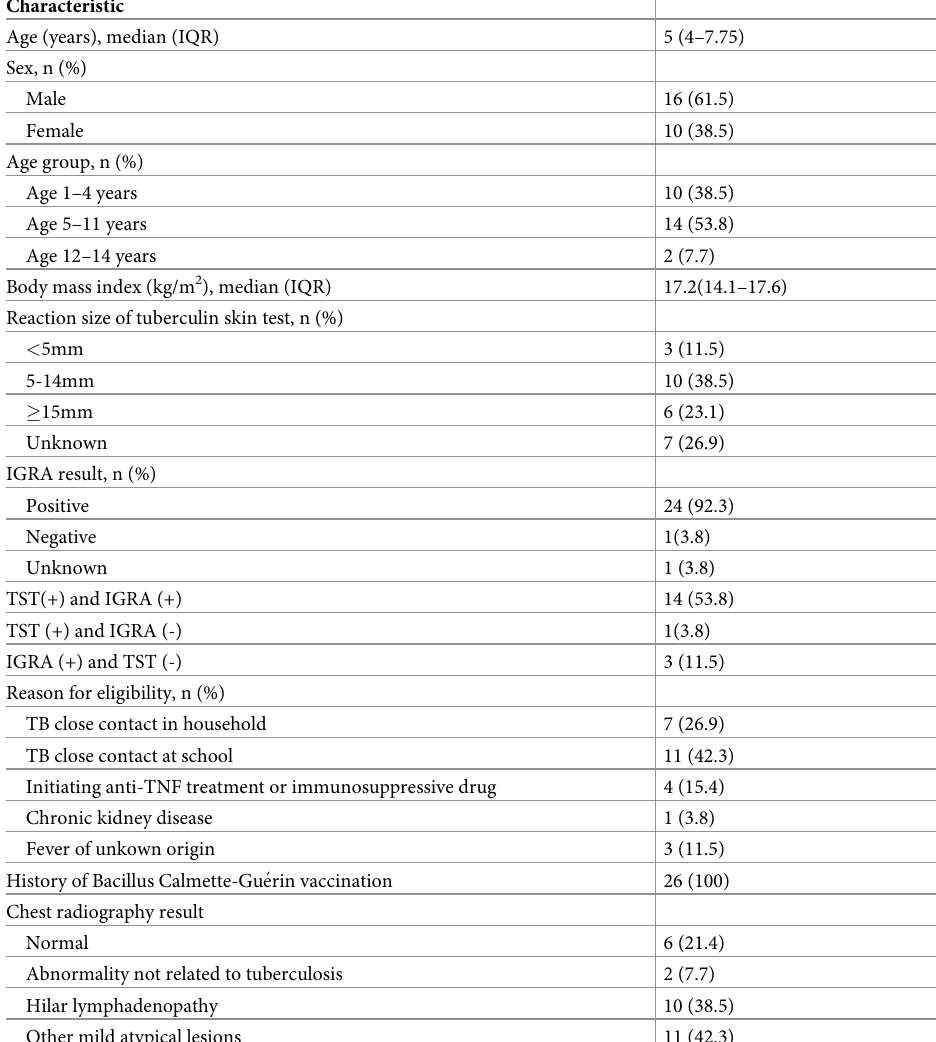
Table 1. Clinical and demographic characteristics of children in the 3 months of weekly rifapentine and isoniazid for tuberculosis preventive treatment (N =